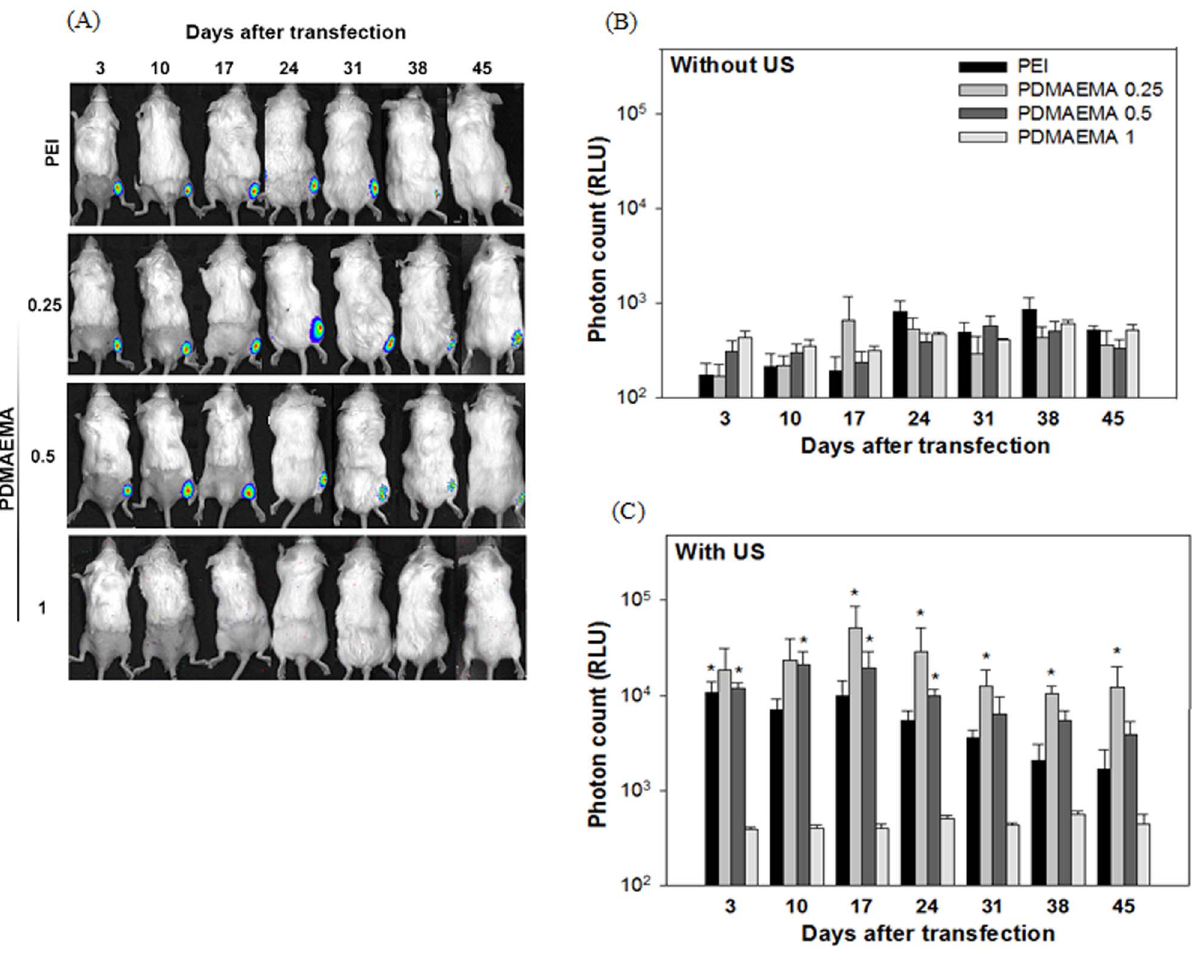
Figure 5. Expression duration of invivo transfected plasmid DNA. DNA (10 m g) was gently mixed with PEI at an N/P ratios of 0.5 or PDMAEMA at weight ratios of 0.25, 0.5 and 1. DNA/PEI and PDMAEMA complexes were then injected into the thigh muscle of mice and transfected by sonoporation. Luciferase activity in Balb/C mice was measured by an IVIS system on gene transfection with (right leg) or without (left leg) US exposure. (A) Quantification of the signal produced in mice muscle after transfection of each formulation (B) without and (C) with US exposure. All results are expressed as the mean 6 SEM for five independent measurements (n=5). *P , 0.05 vs. PDMAEAM 1.